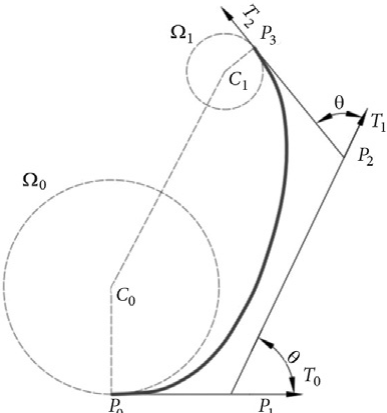
Fig. 7. Schema of C -shaped joining of the circular arcs using a cubic C -Bezier